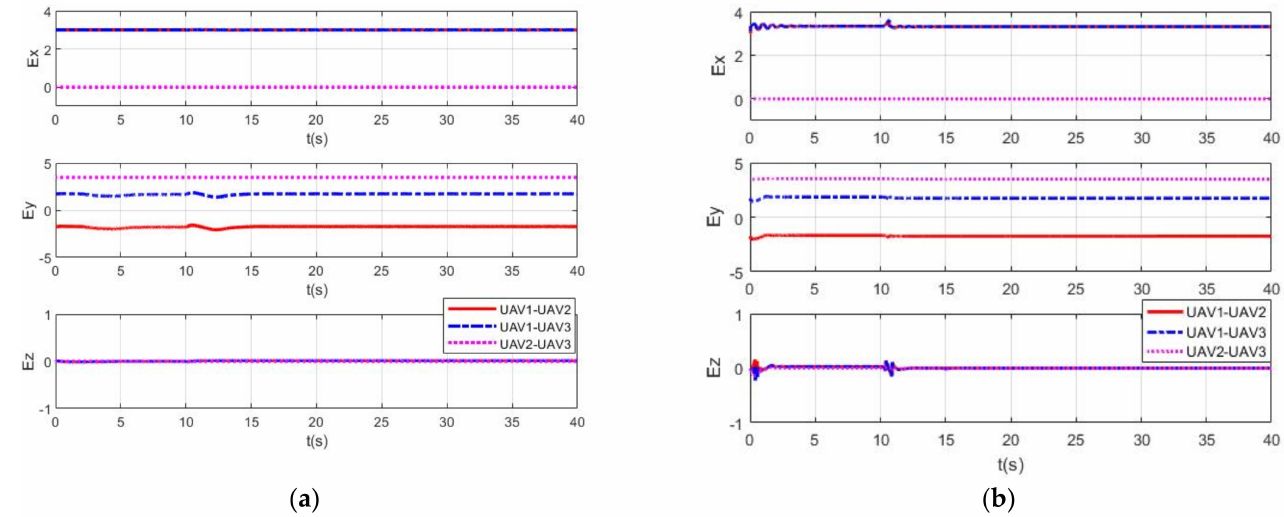
Figure 9. Distance between UAVs with SMC ( a ) and MPC ( b ) in the direction of three axes. The condition number of regular MPC (RMPC) and IMPC is shown in Table 1, where the TS of IMPC was about two orders of magnitude less than RMPC, and the RS of IMPC designed in this paper can be greatly reduced compared to the RMPC. The average computation period also demonstrates the superiority of IMPC.